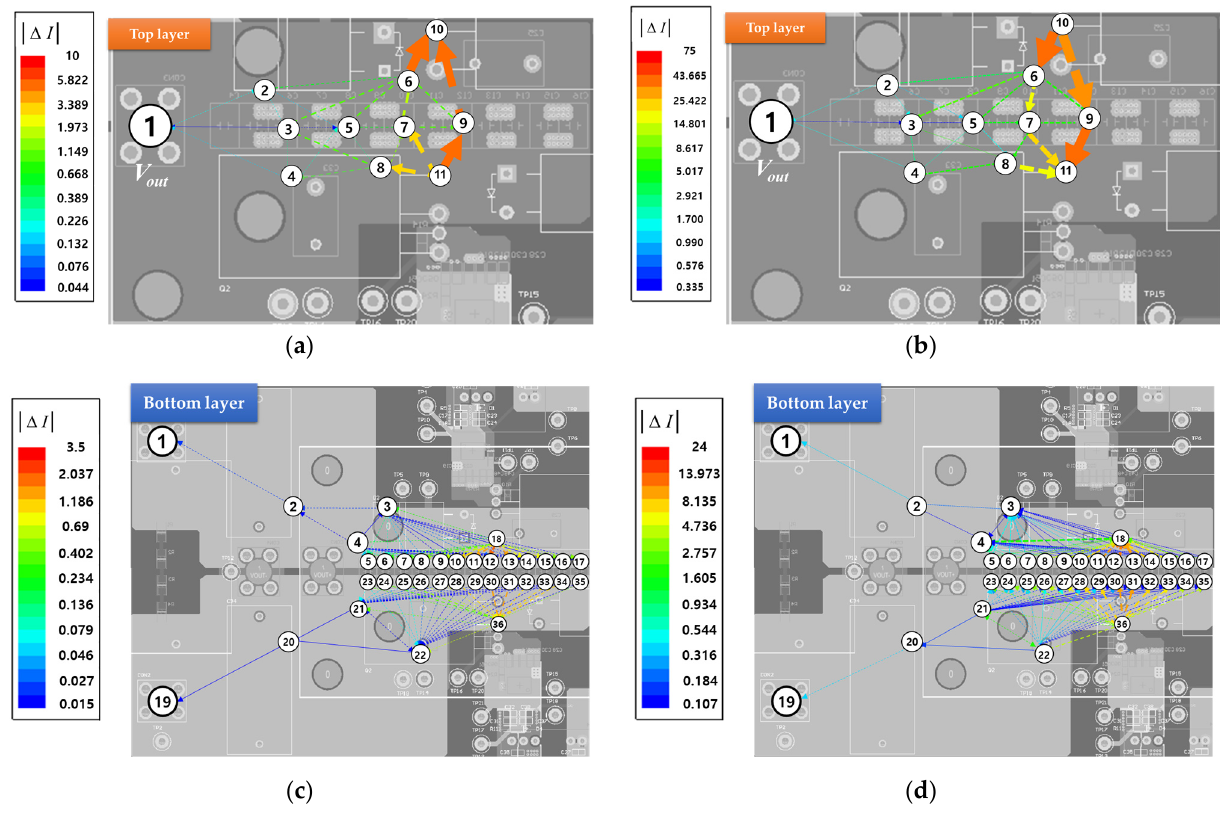
Figure 18. Amount of change in current distribution. ( a ) Turn-off at top layer. ( b ) Turn-on at top layer. ( c ) Turn-off at bottom layer. ( d ) Turn-on at bottom layer.